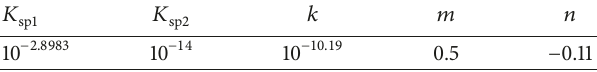
Table 2: Chemical parameters of pyrite oxidation dissolution. 𝐾 𝐾 𝑘 𝑚 𝑛 sp 1 sp 2 10 −2.8983 10 −14 10 −10.19 0.5 −